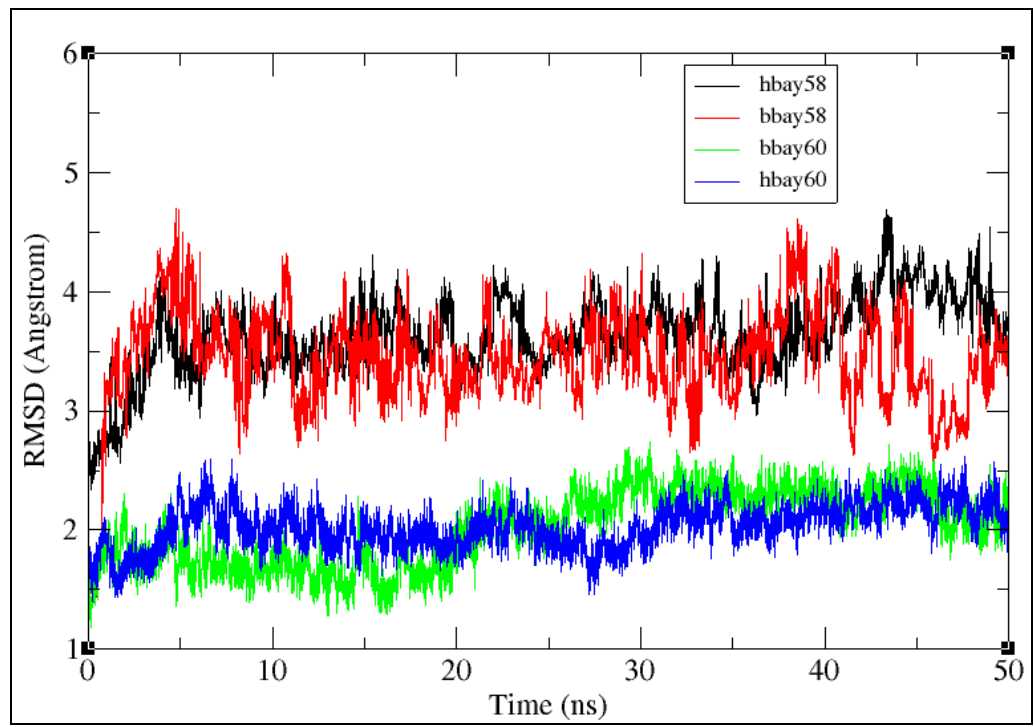
Figure 4. 50 ns RMSD trajactories of the backbone atoms of BAY58-2667 and BAY60-2770 bound b H-NOX and h H-NOX complexes (bbay58, hbay58, bbay60 and hbay60). Y-axis represents the value of RMSD in Angstroms (Å) and the X-axis shows the duration of the simulation trajectory in nanoseconds (ns). All the four trajectories are traced in different colors, BAY58-2667 bound h H-NOX (hbay58) is represented in black; BAY58-2667 bound b H-NOX (bbay58) is shown in red; BAY60-2770 bound b H-NOX (bbay60) is illustrated in green and BAY60-2770 bound h H-NOX (hbay60) is shown in blue.